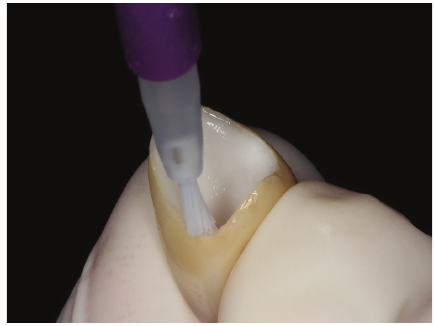
Figure 14: Final aspect of treatment, immediately after cementation procedure.